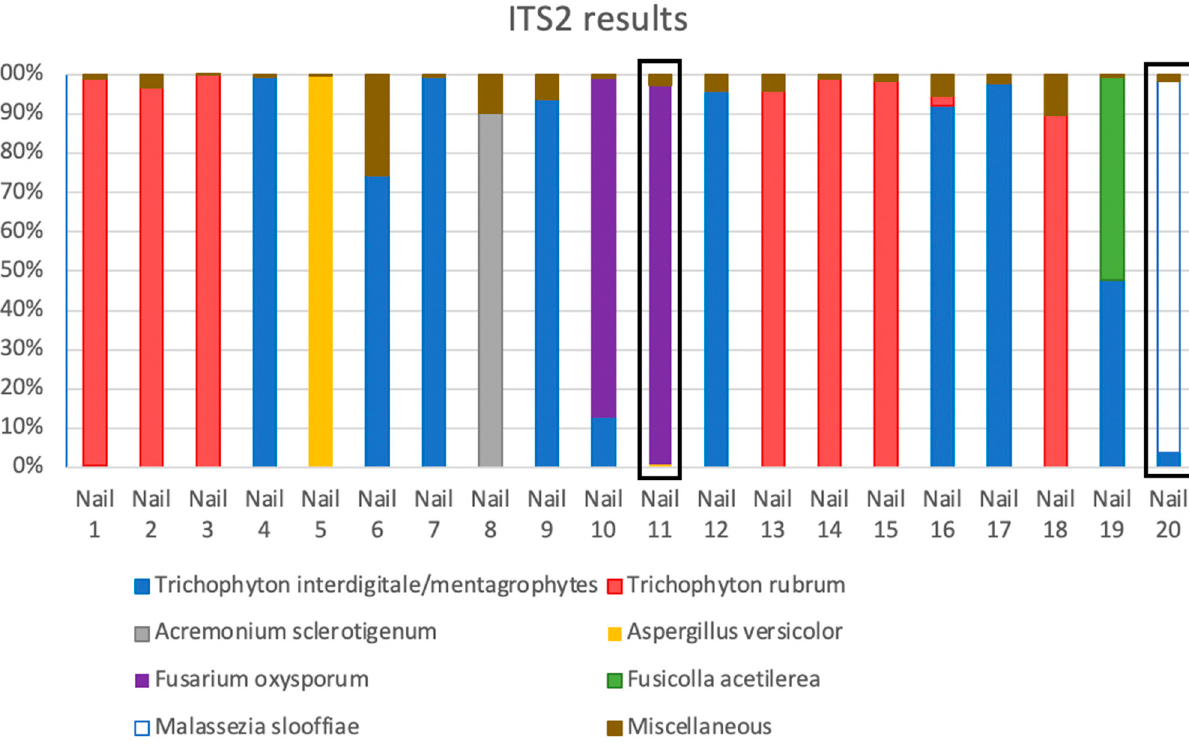
Figure 2. Main fungal species detected in mycotic and control nails. Stacked histograms show dominant species results of ITS2 for all nails. Normal control nails are boxed in black.